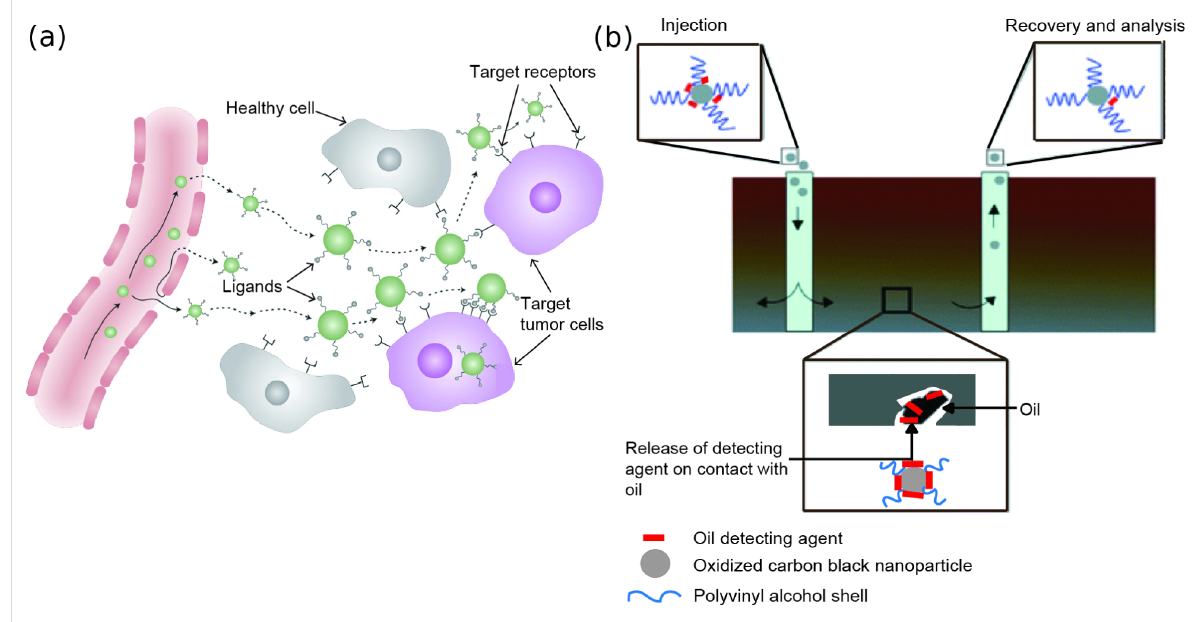
Figure 1: (a) Schematic of drug-carrying nanoparticles targeting cancer cells and releasing their therapeutic payload resulting in death of the cancer cell. Reprinted by permission from Macmillan Publishers Ltd [8], copyright 2011. (b) Showing the process of oil detection with nanoparticles. The carbon-black nanoparticles are coated with an oil-detecting agent. After injection into the ground, the agent is released on contact with hydrocarbons and this is used as an indication of the presence of oil on recovery and analysis of the nanoparticle [10]. Reproduced by permission of the Royal Society of